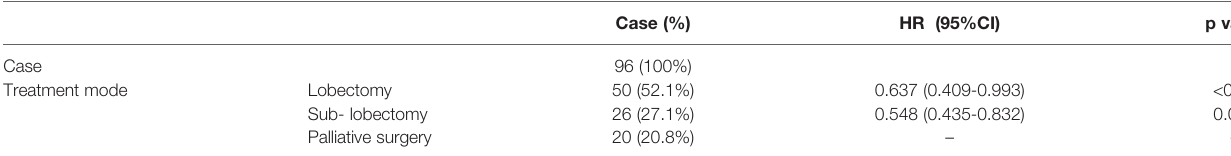
TABLE 3 | Multivariate Cox model for overall survival in the VATS